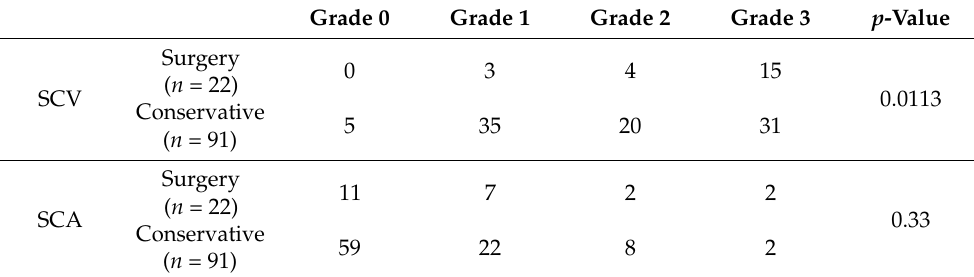
Table 2. Breakdown of SCV and SCA stenosis grade in MRI-MIP images.